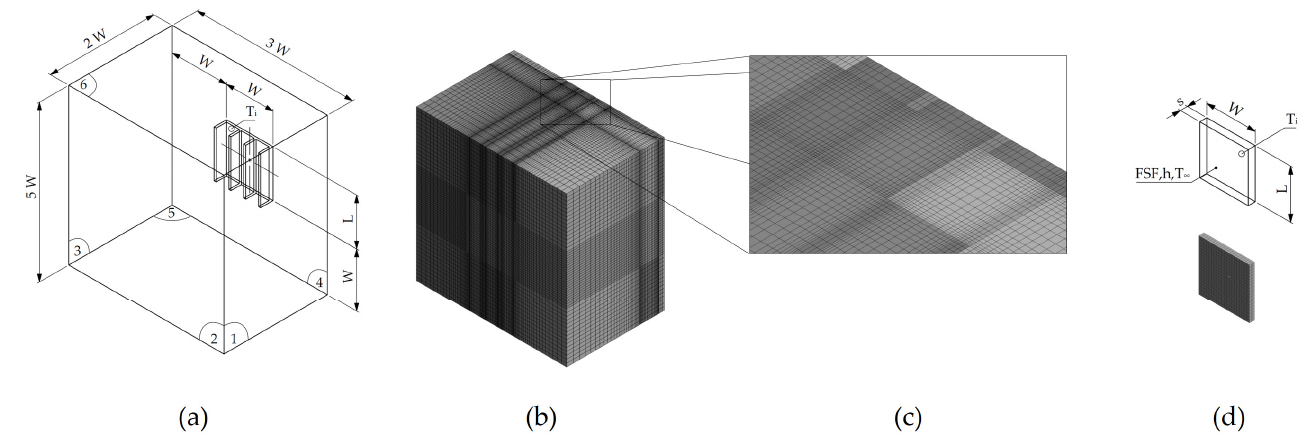
Figure 2. CFD simulation model ( a ), discretized CFD computational domain ( b ), a detailed CFD grid view ( c ), solid-state simulation model, and the meshed domain ( d ).